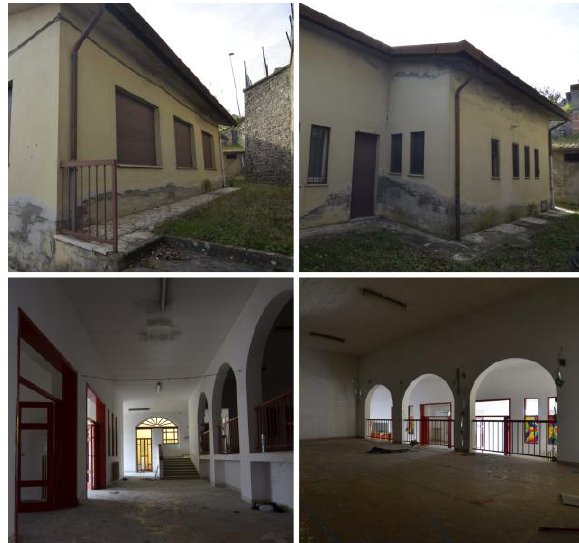
Figure 1. Current status of the Municipal Nursery School of Anghiari.